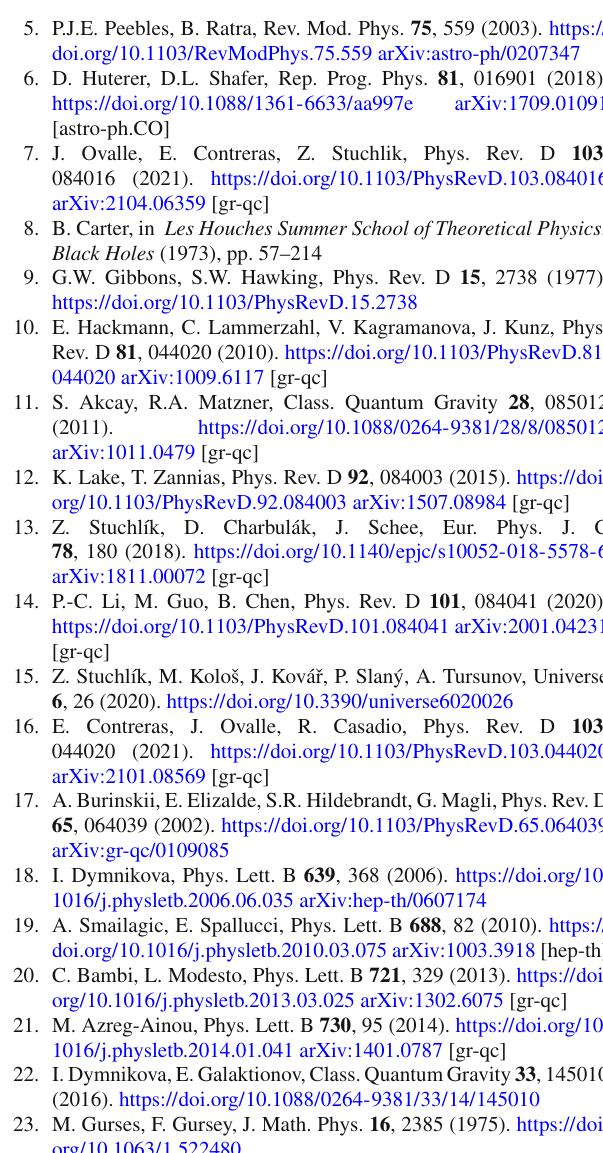
Fig. 2 Anisotropy (cid:15)( r ,θ) induced around black holes. The equatorial plane remains isotropic, however the anisotropy increases with a and is maximum around the poles, in agreement with Eq. (18). We take (cid:2)/κ =